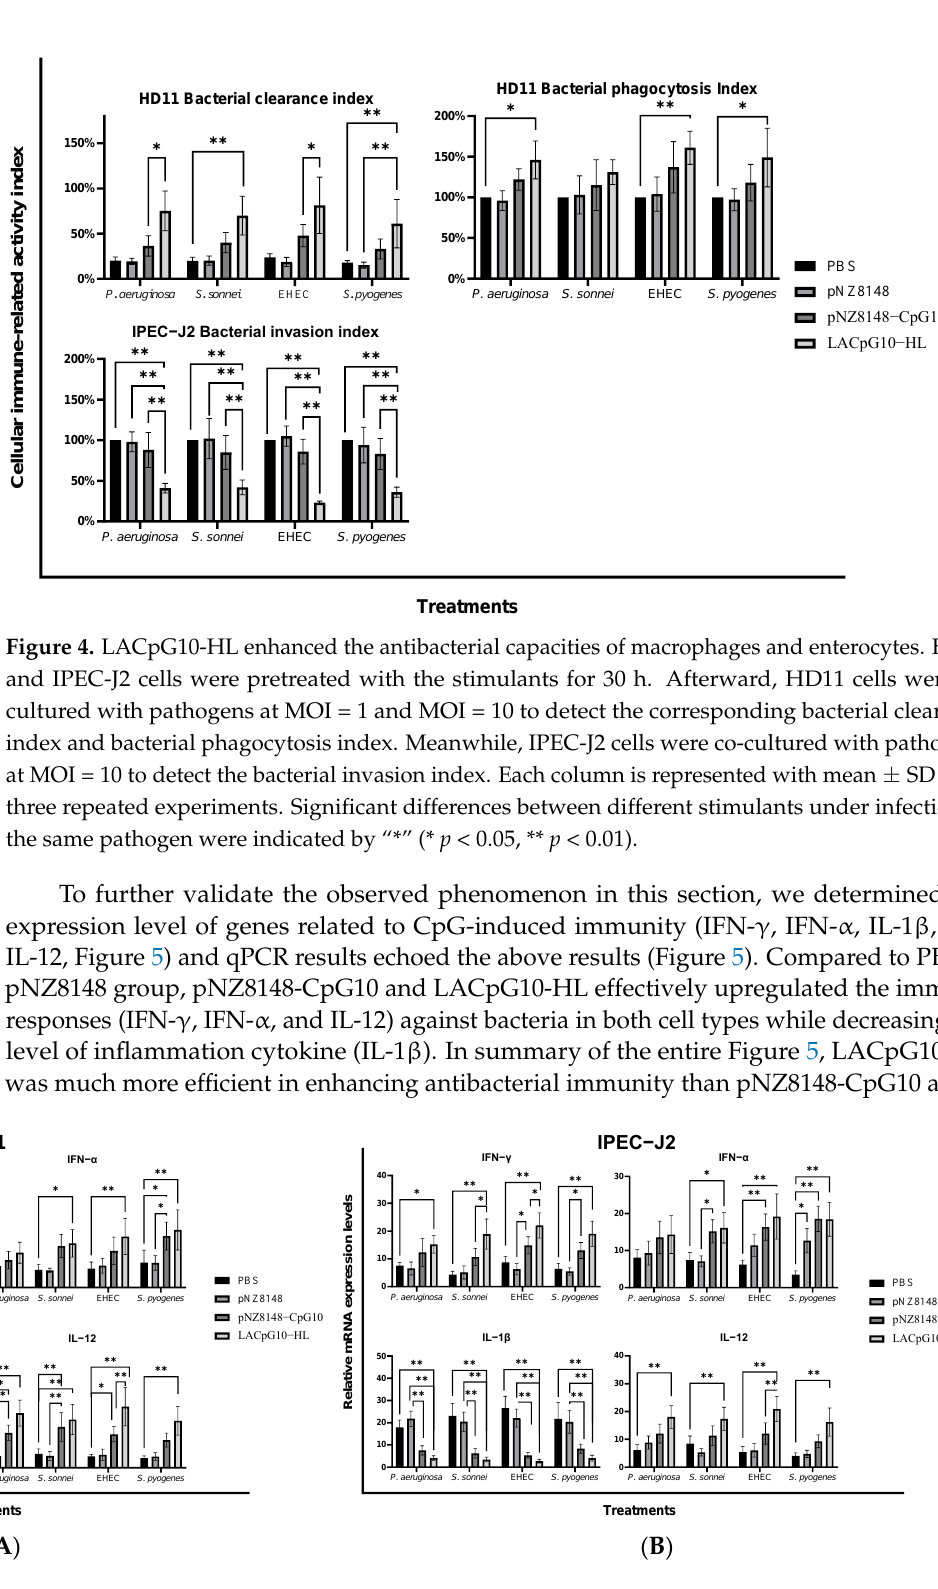
Figure 5. LACpG10-HL boosted antibacterial immunity in HD11 and IPEC-J2. The two cells were infected with the pathogens at MOI = 10 to detect the relative mRNA expression levels of cytokine genes. ( A ) presented the results in HD11 and ( B ) presented those in IPEC-J2. The reference gene of mRNA detection was β -actin. Each column is represented with mean ± SD from three repeated experiments. Significant differences between different stimulants under infection of same pathogen were indicated by “*” (* p < 0.05, ** p < 0.01).